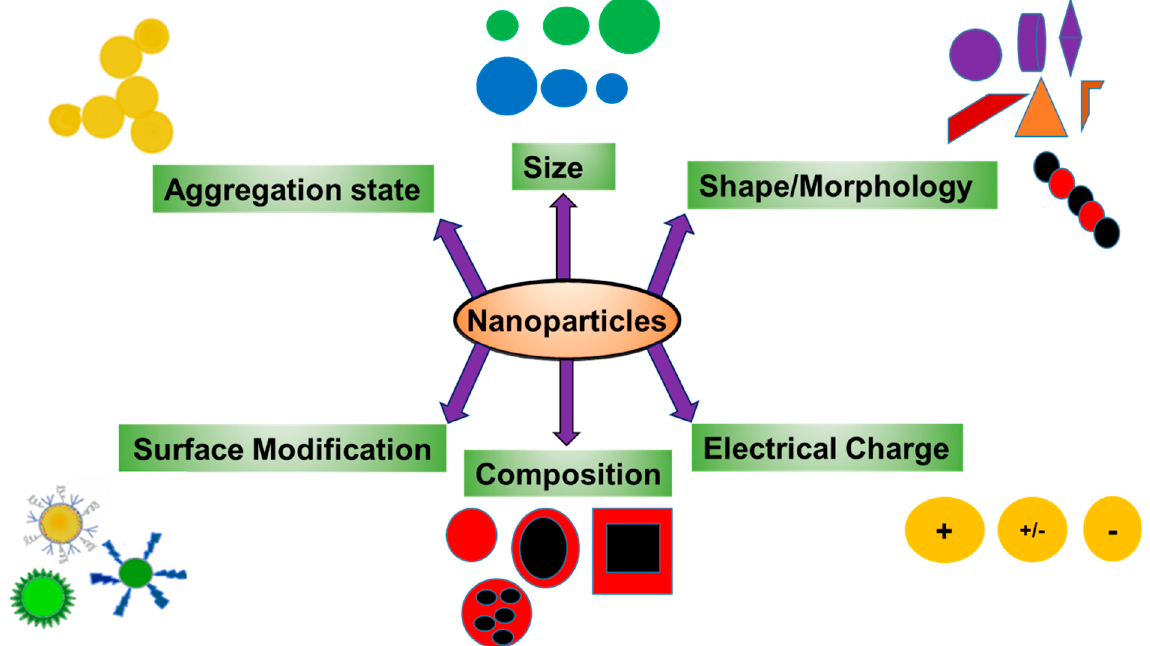
Figure 4. Physicochemical properties of nanoparticles that dictate their toxicities. Size, surface modification, surface charge, composition, shape and aggregation state of NPs are key factors in dictating NPs distribution in different organ systems following their exposure.